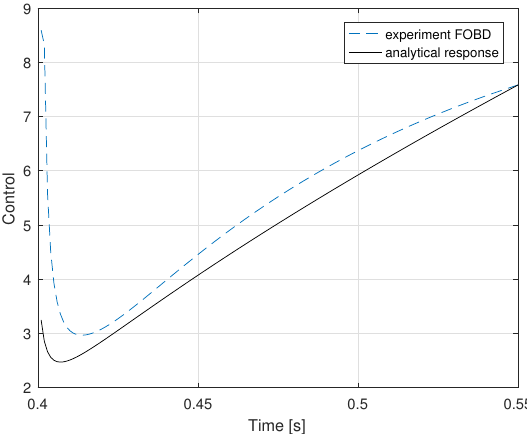
Figure 12. The step-response of FOPID using CFE vs. the analytical response, α = 0.75, β = 0.75. IAE = 0.0686, and ISE =